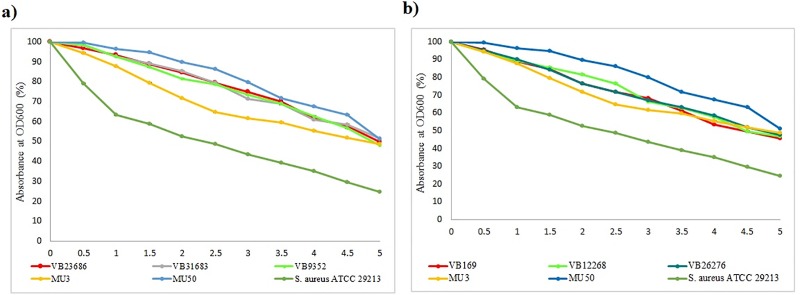
Triton X-100 induced autolysis in teicoplanin resistant MRSA (TR-MRSA).Lysis of cells was measured as the percentage of absorbance measured at OD600nm. The data are represented as mean ± mean standard deviation (SD). a) Triton X-100 induced autolysis in TR-MRSA with MICs of 16 and 32 μg/ml; b) Triton X-100 induced autolysis in TR-MRSA with MIC of 4 μg/ml. The autolysis rate of all TR-MRSA strains was significantly higher than S. aureus ATCC 29213 (p <0.05). VB9352 and VB31683 showed decreased lytic activity than MU3 (p <0.01).